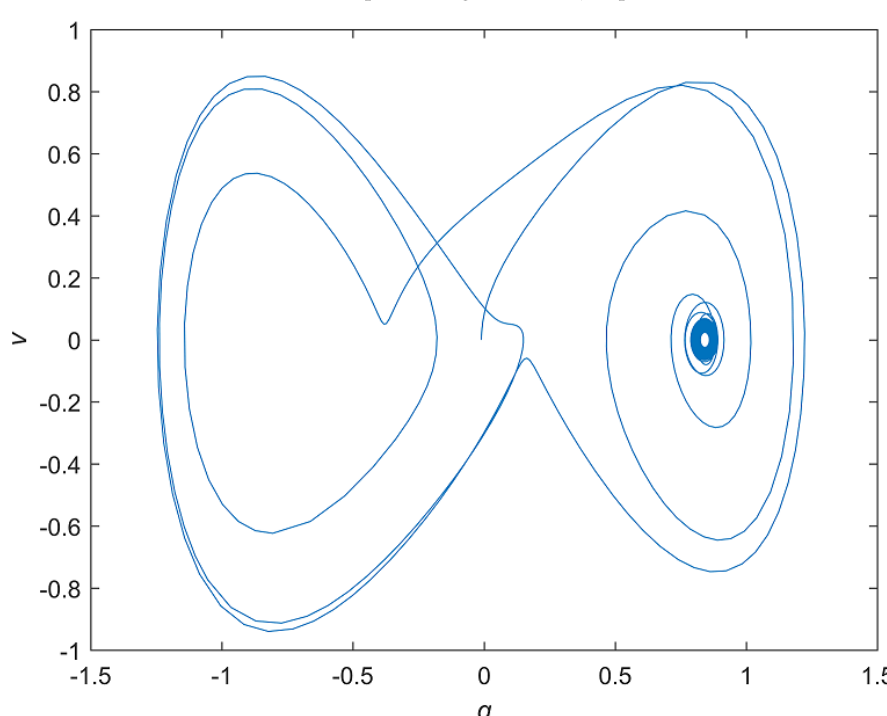
Figure 2. The phase diagram in the q - v